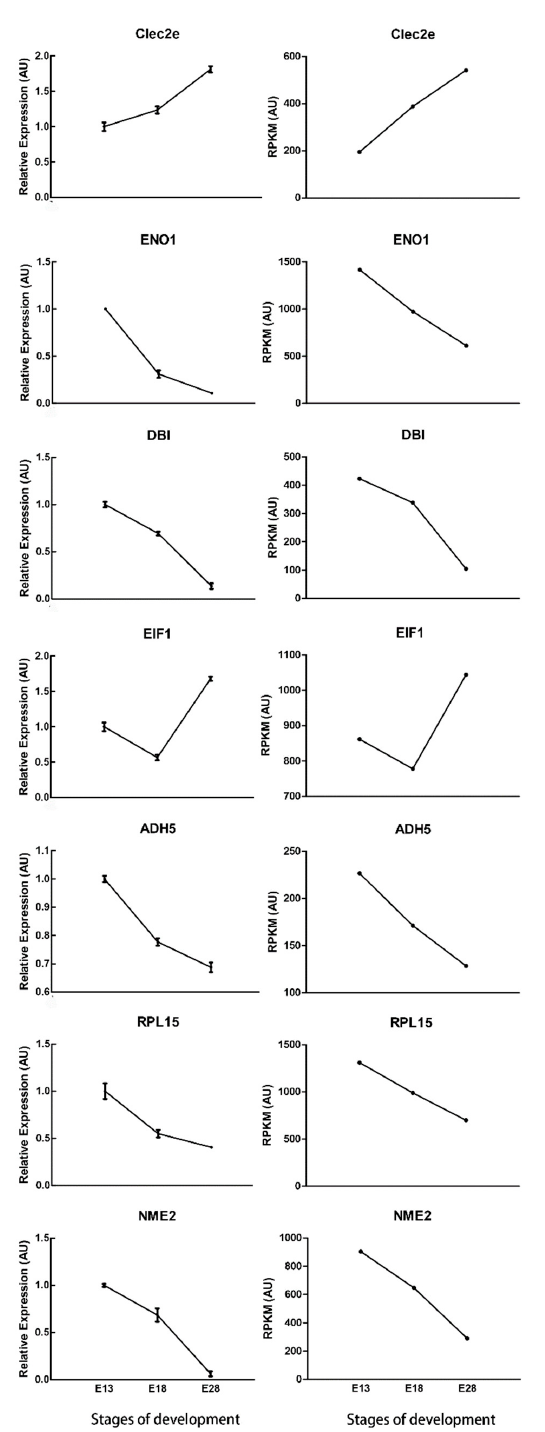
bands with the expected sizes and the genes expression levels detected by qRT-PCR correlated with correlated with the RNA-Seq data (Figure 7), confirming the reliability and precision of the RNA-Seq data.